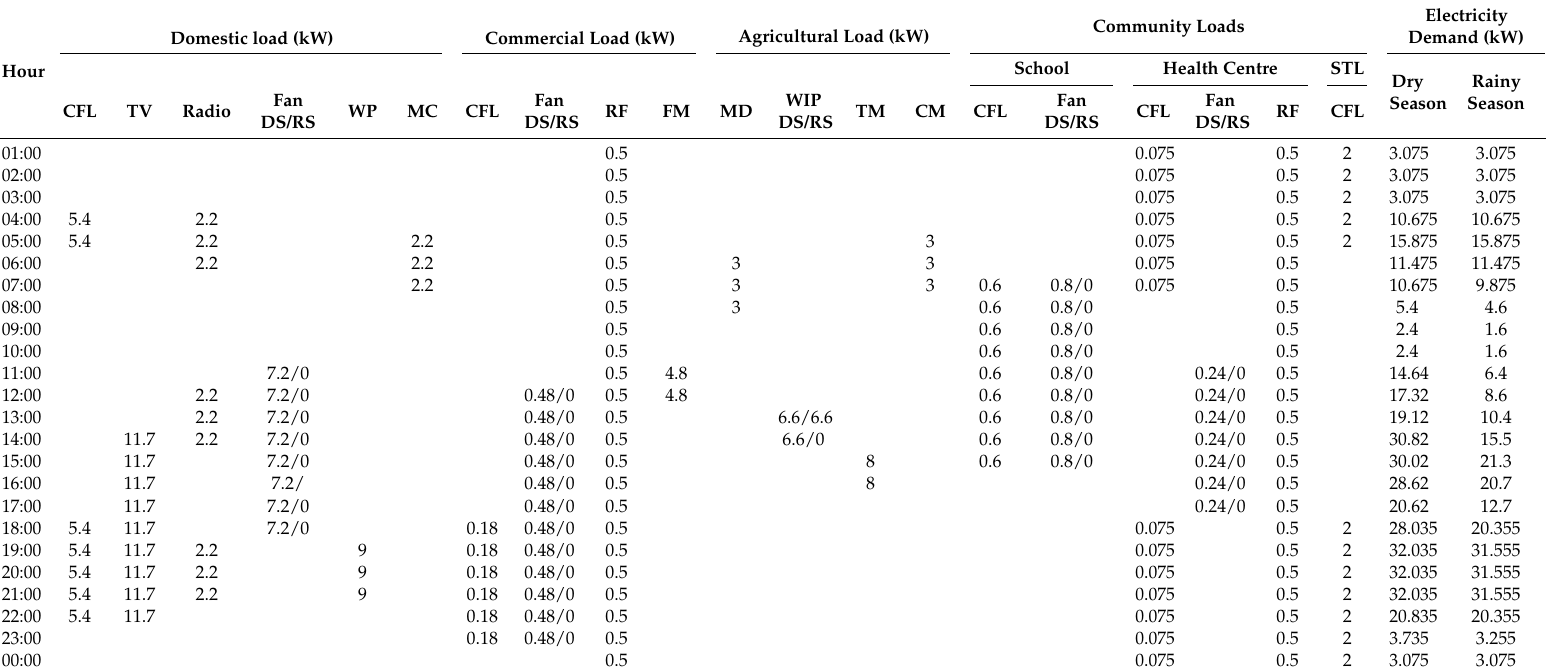
Table 4. Hourly electricity demand of the study location during dry and rainy